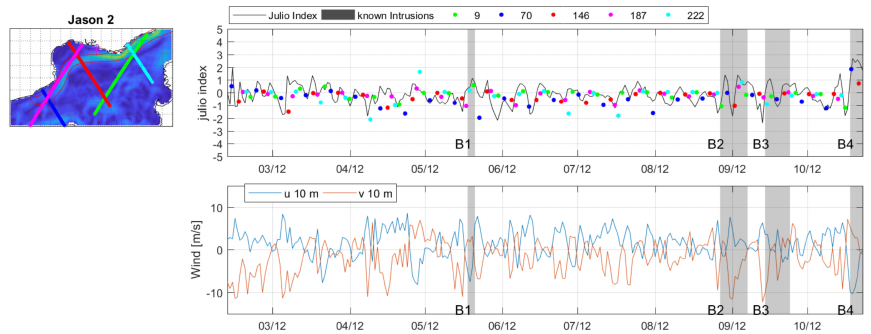
Figure 4. Results of the application of the regressive random forest algorithm to observational data, (Jason 2). Right panel shows the map of the tracks considered for the period 12 February–23 October 2012, colors refer to the tracks number in the legend on the right panel. On the right panel the comparison between the JULIO index (J ind ) (as a black line) and the predicted normalized Flux (Fn p for each track (color dots with reference to the upper legend) is shown in the upper panel. The Lower panel show the corresponding mean daily horizontal winds. In both panels, the periods corresponding to well-known intrusion events are highlighted in gray.